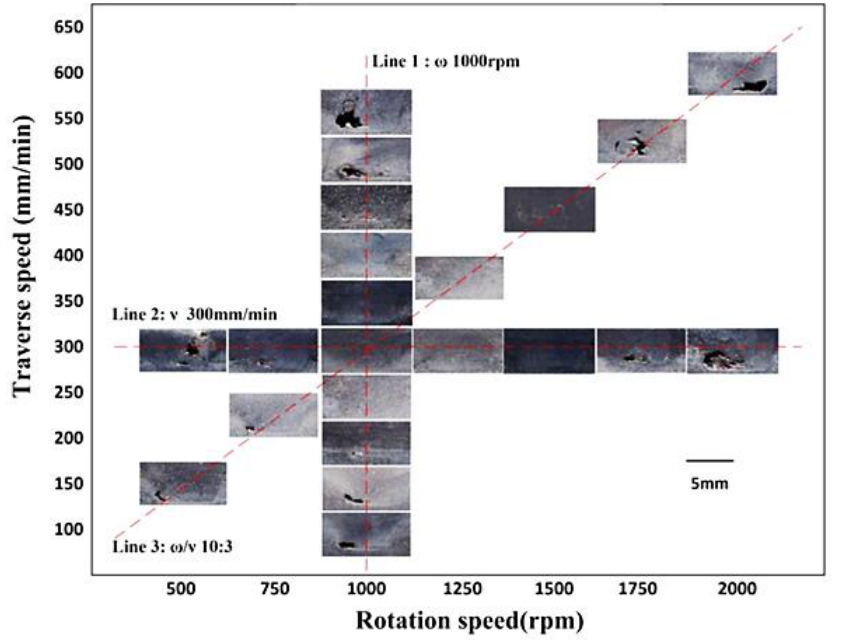
Figure 8. Rotation and transverse speed optimization by analyzing the major defects produced during FSLW of Al-2024 (reprinted from [63] permission not required).